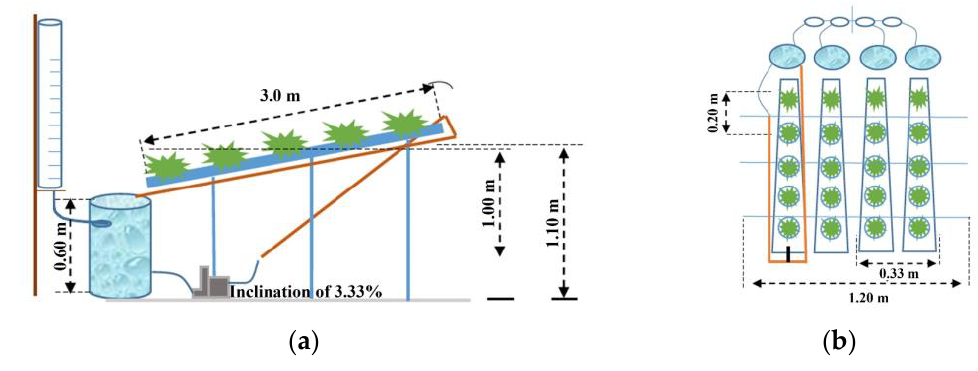
Figure 3. Side view ( a ) and top view ( b ) of the experimental plot.